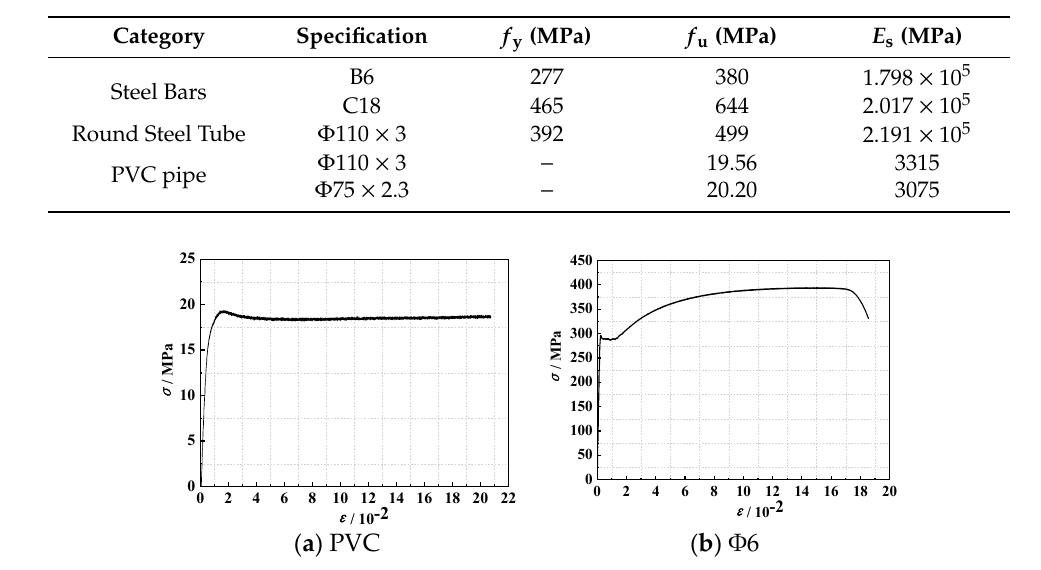
Table 3. Physical properties of steel bars and tubes.